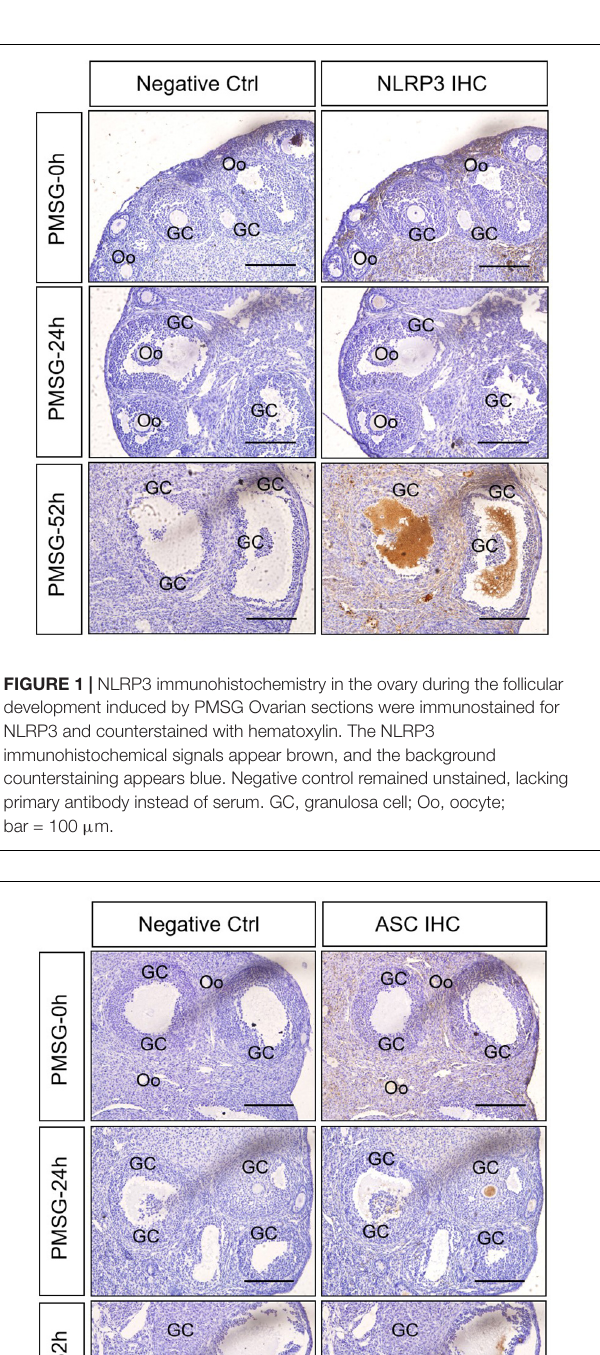
Frontiers in Cell and Developmental Biology |